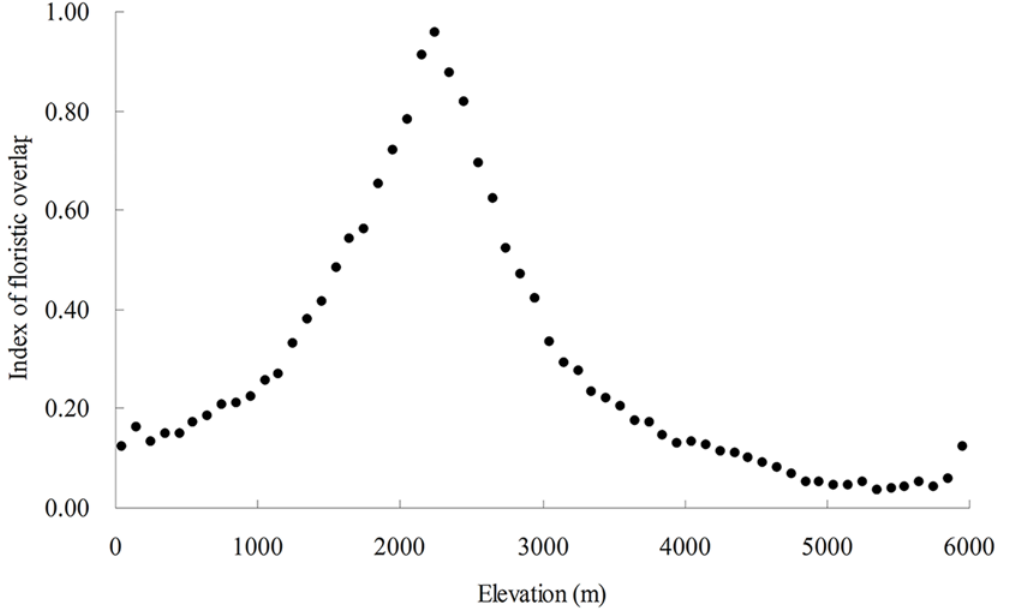
Fig 4. The index of floristic overlap with